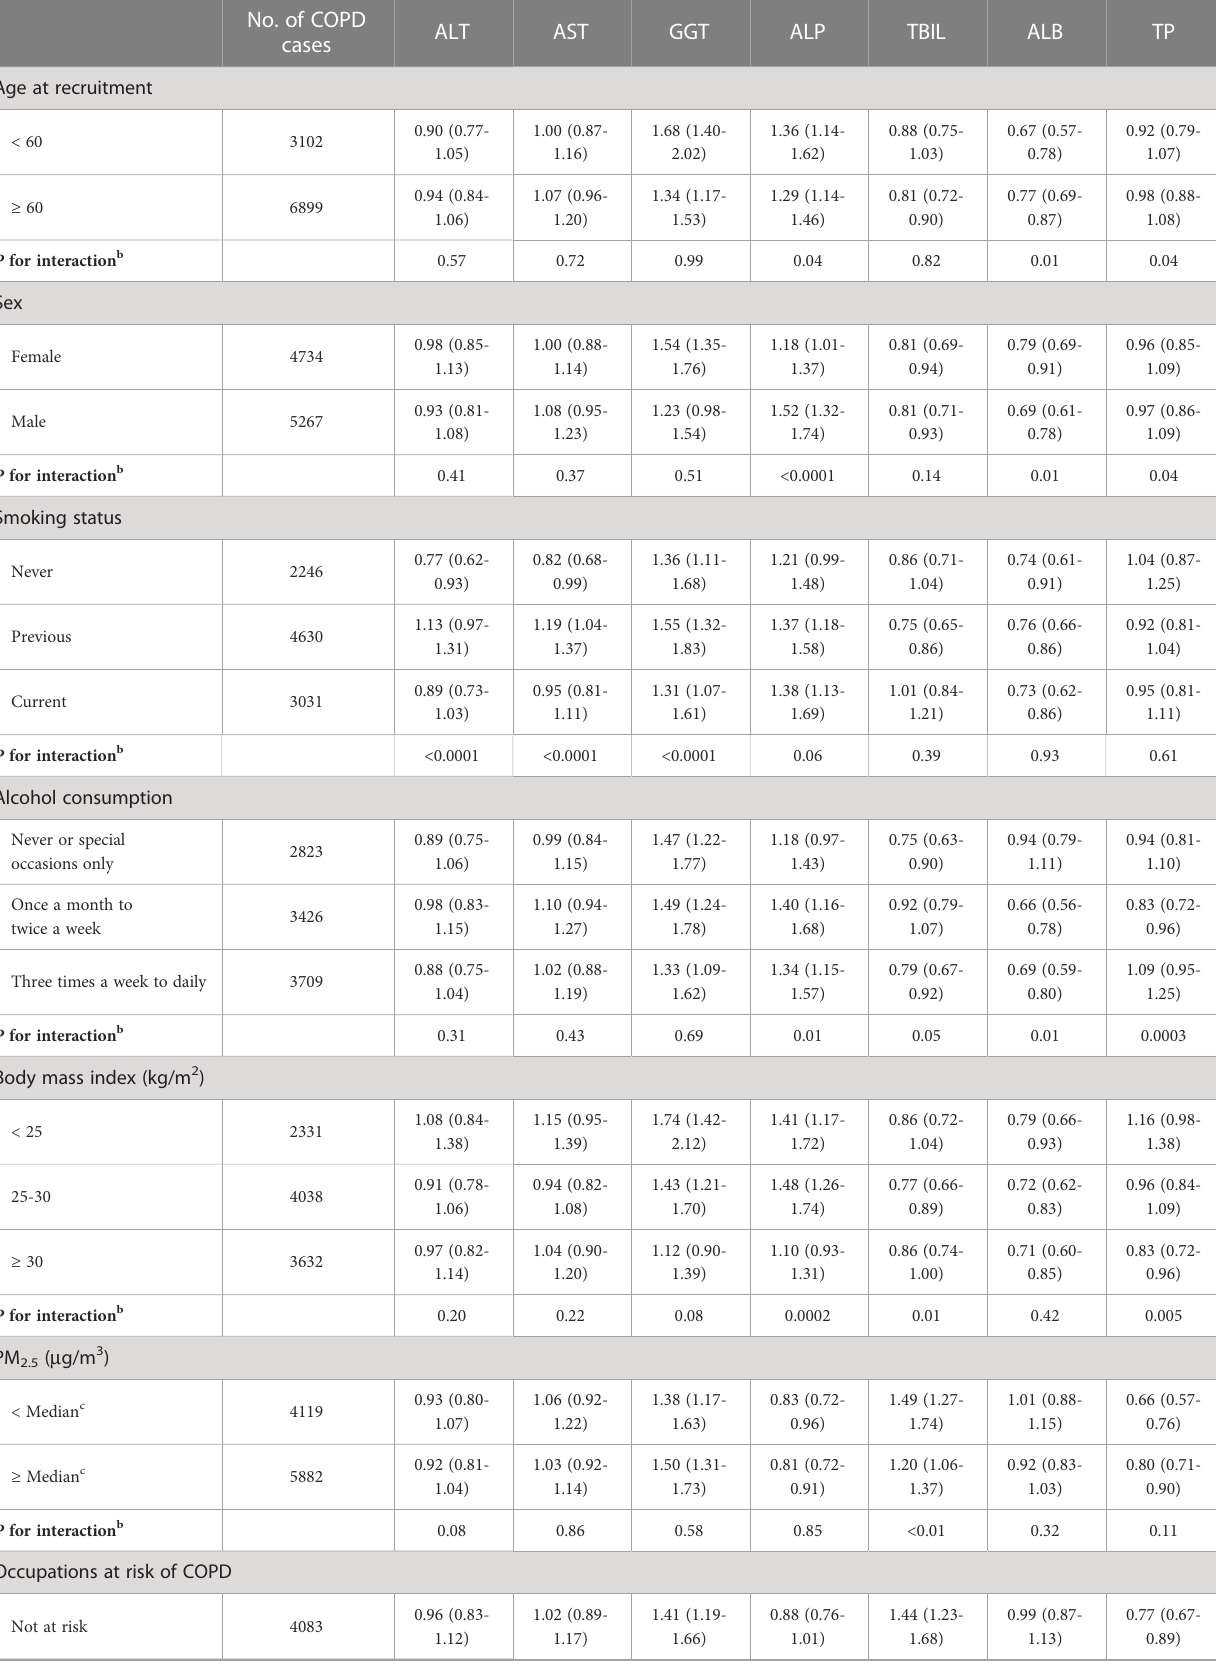
TABLE 3 Strati fi ed analyses of the association between circulating levels of liver function markers and COPD risk a . No. of COPD